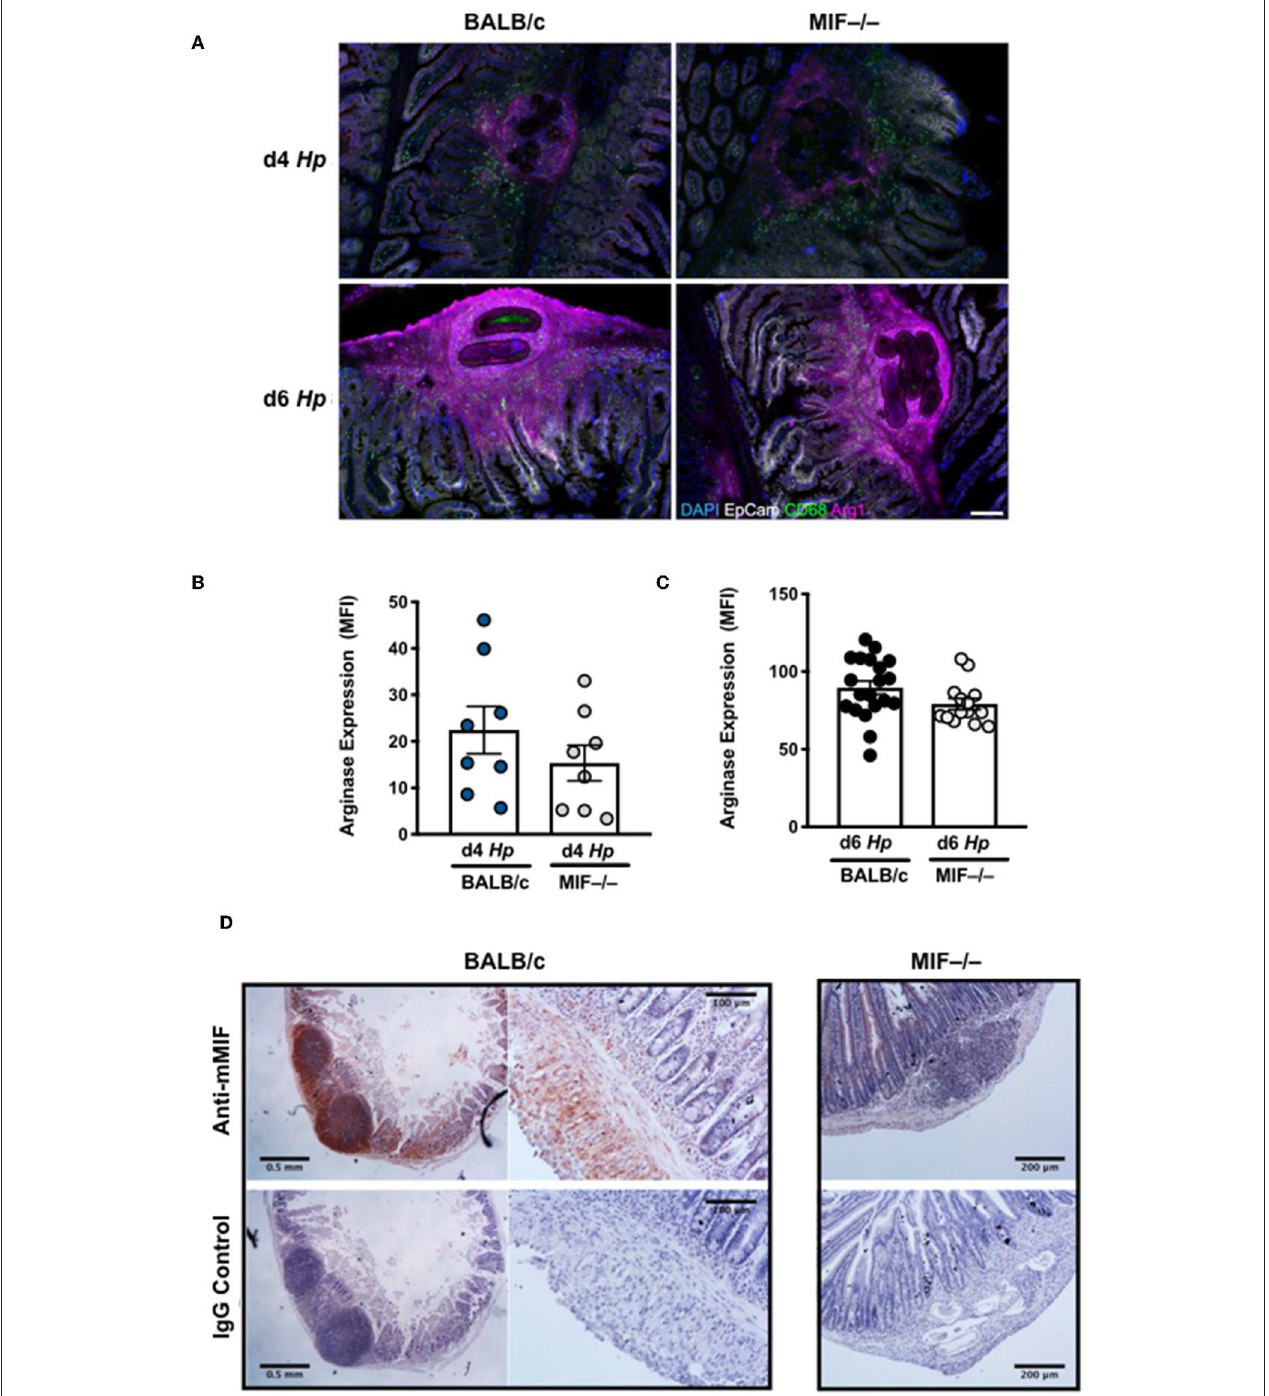
FIGURE 6 | Myeloid cell infiltration around tissue larvae of H. polygyrus with expression of Arginase-1 and MIF. (A) M2 macrophages infiltrate the infection site of H. polygyrus larvae in the small intestine. Arginase, CD68 and EpCam staining of granulomas around larval parasites in the small intestinal submucosa at days 4 and 6 of H. polygyrus infection in BALB/c and MIF − / − mice. Images are representative of two experiments with similar results. (B,C) Analysis of intensity of Arginase staining in granulomas at days 4 and 6 after H. polygyrus infection. For each group at each time point, granulomas were analyzed from 4 individual animals, and intensity data pooled. Each data point represents an individual granuloma. (D) MIF is expressed in the infection site of H. polygyrus larvae in the small intestine. Intense staining of polyclonal rabbit anti-MIF antibody is observed in the granulomas around larval parasites in the small intestinal submucosa at day 6 of H. polygyrus infection in BALB/c mice, but not in MIF − / − animals or in sections stained with isotype control IgG. In addition, widespread specific antibody staining is seen throughout the submucosal tissue. Images were collected on a Leica compound microscope. Scale bars represent 500 and 250 µ m.